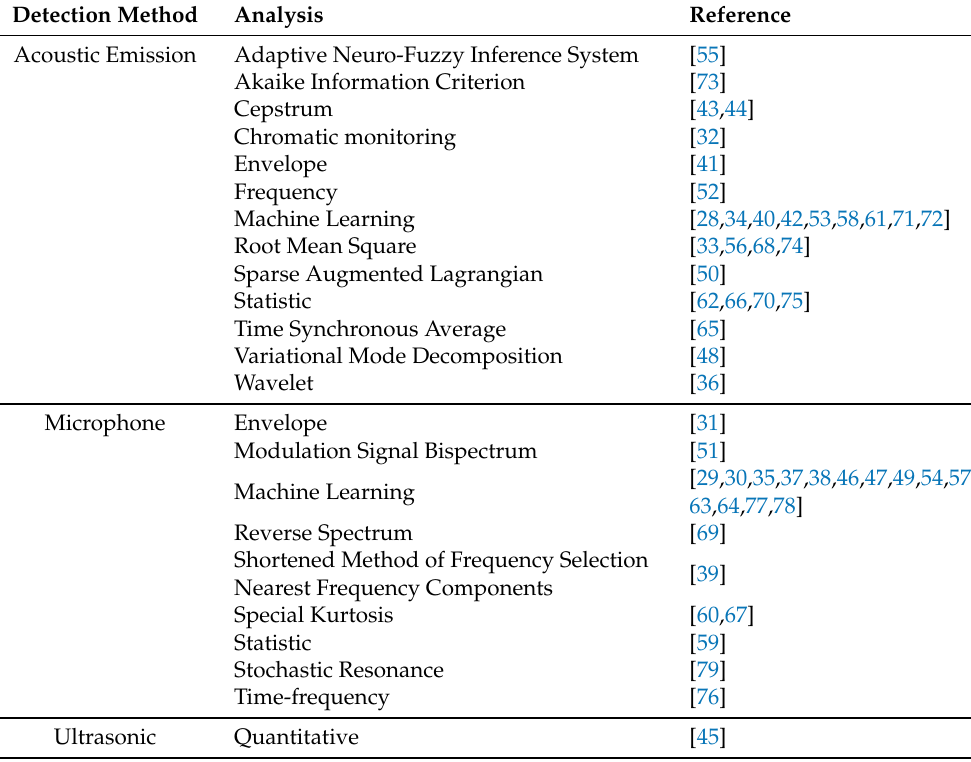
Table 8. Approach methods used to detect failures based on acoustic